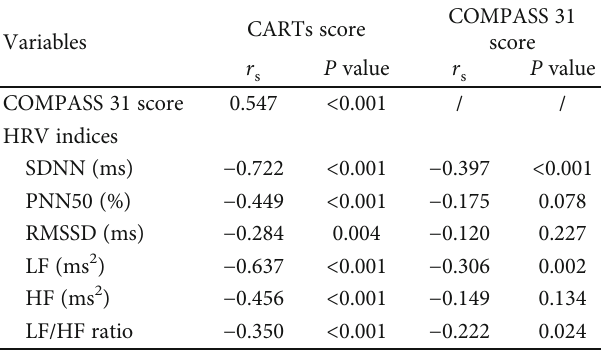
Table 3: Correlation between COMPASS 31 score, HRV indices, and